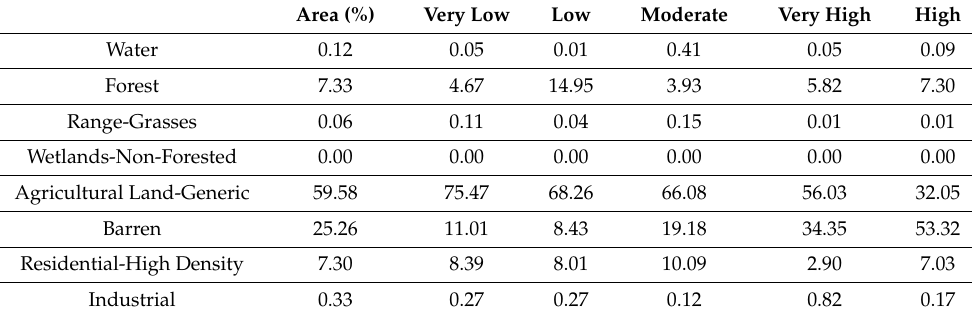
Table 9. Soil erosion rate in relation to land use using SWAT model.